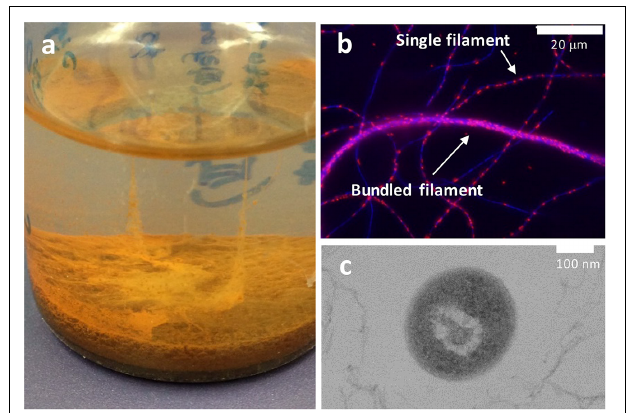
FIGURE 1 | (a) Photograph showing a filamentous structure formed by strain 110S between the surface of the liquid medium and ferrihydrite precipitate. The liquid medium is approximately 2 cm in depth. (b) Single filaments and a bundled structure of strain 110S were visualized using an overlay of 4 (cid:48) ,6-diamidino-2-phenylindole (DAPI, blue) staining and 5-cyano-2,3-di-p-toluyl-tetrazolium chloride (CTC, red) staining. Blue and red spots indicate the localization of double-stranded DNA and NAD(P)H, respectively. (c) Cross-sectional TEM image of strain 110S showing its smooth surface structure. Scale bars indicate 20 µ m (b) and 100 nm (c)